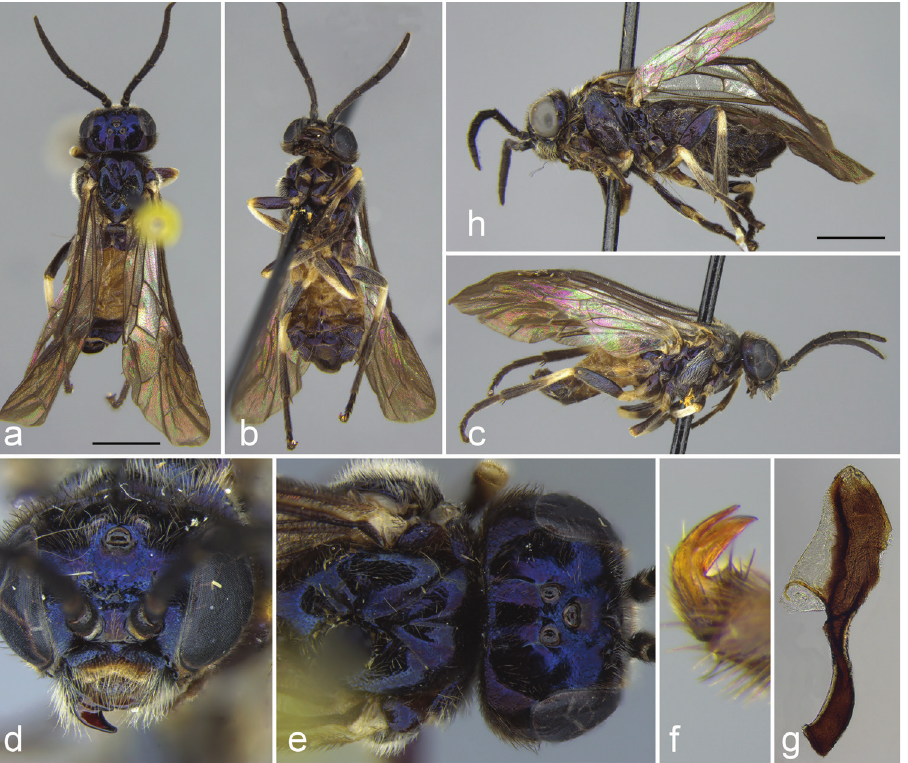
Figure 2. Neostromboceros albicomus , males. a–f pale specimen a dorsal (scale 2 mm) b ventral c lateral d face e head and thorax, dorsal f claw of hind leg g–h dark specimen g penis valve h ventrolateral view (scale 2